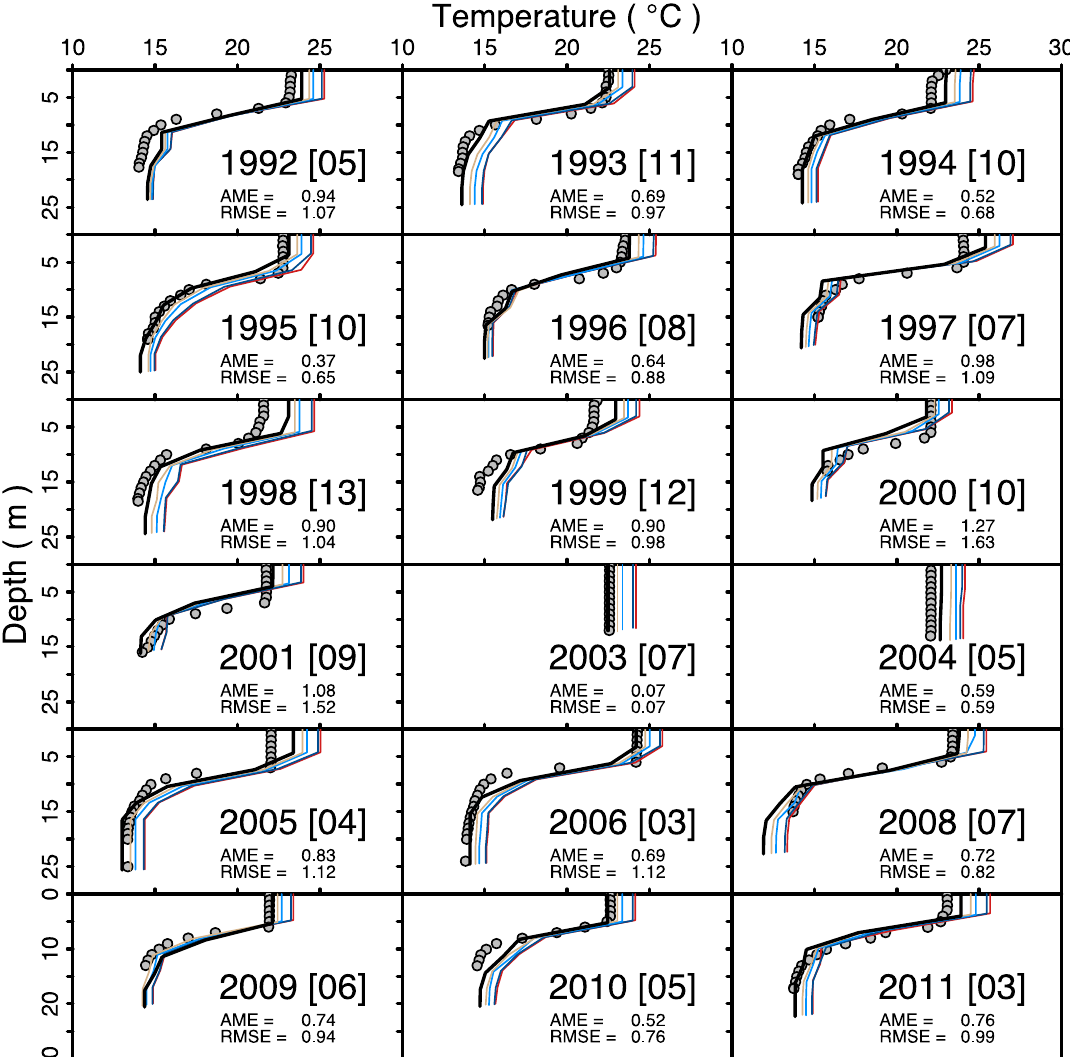
Figure 5. Observed and modeled temperature profiles in October from 1992 to 2011. Circles indicate observed temperature and lines indicate modeled values, following the legend from Figure 4. The day of the month (October) is given in brackets.